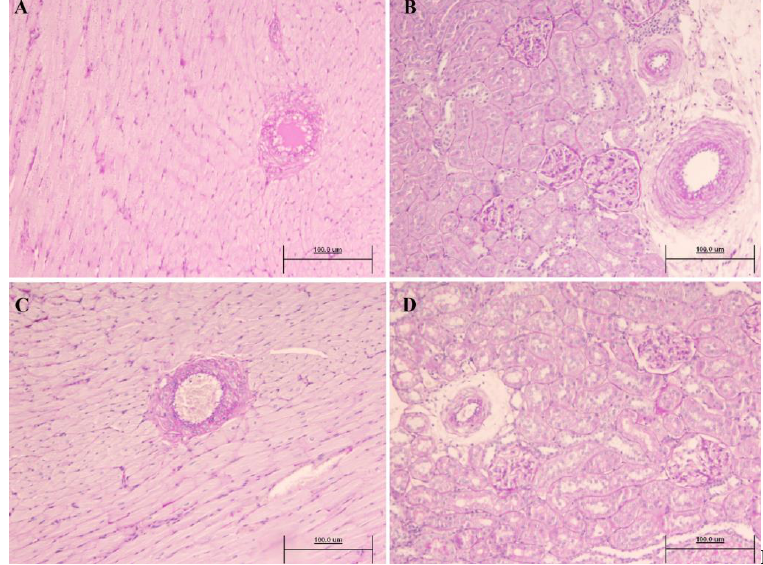
Figure 6. Absence of heart parenchyma damage, and no tubulointerstitial, glomerular or vascular kidney lesions in in SHR6 (( A ) and ( B )) and SHR12 (( C ) and ( D )). Bar: 100 micrometers (PAS, original magnification ×